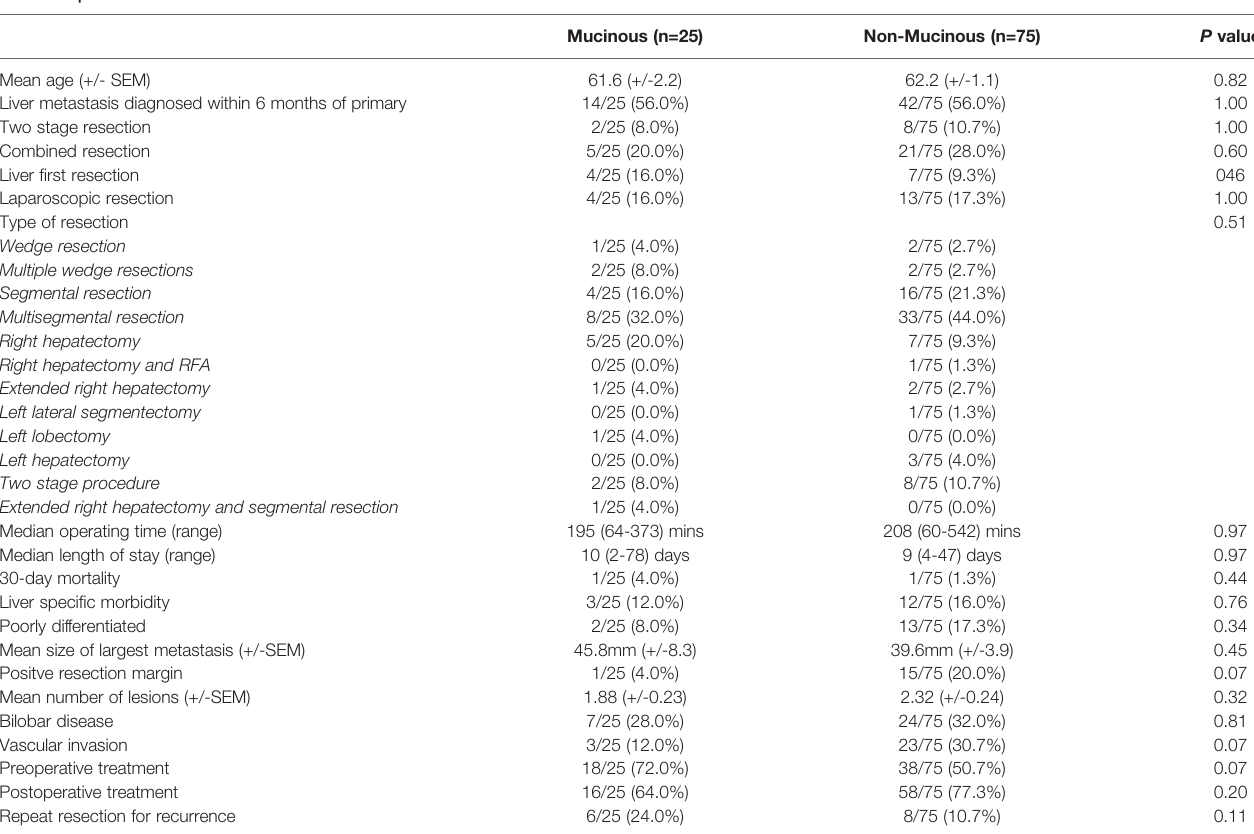
TABLE 2 | Liver metastases